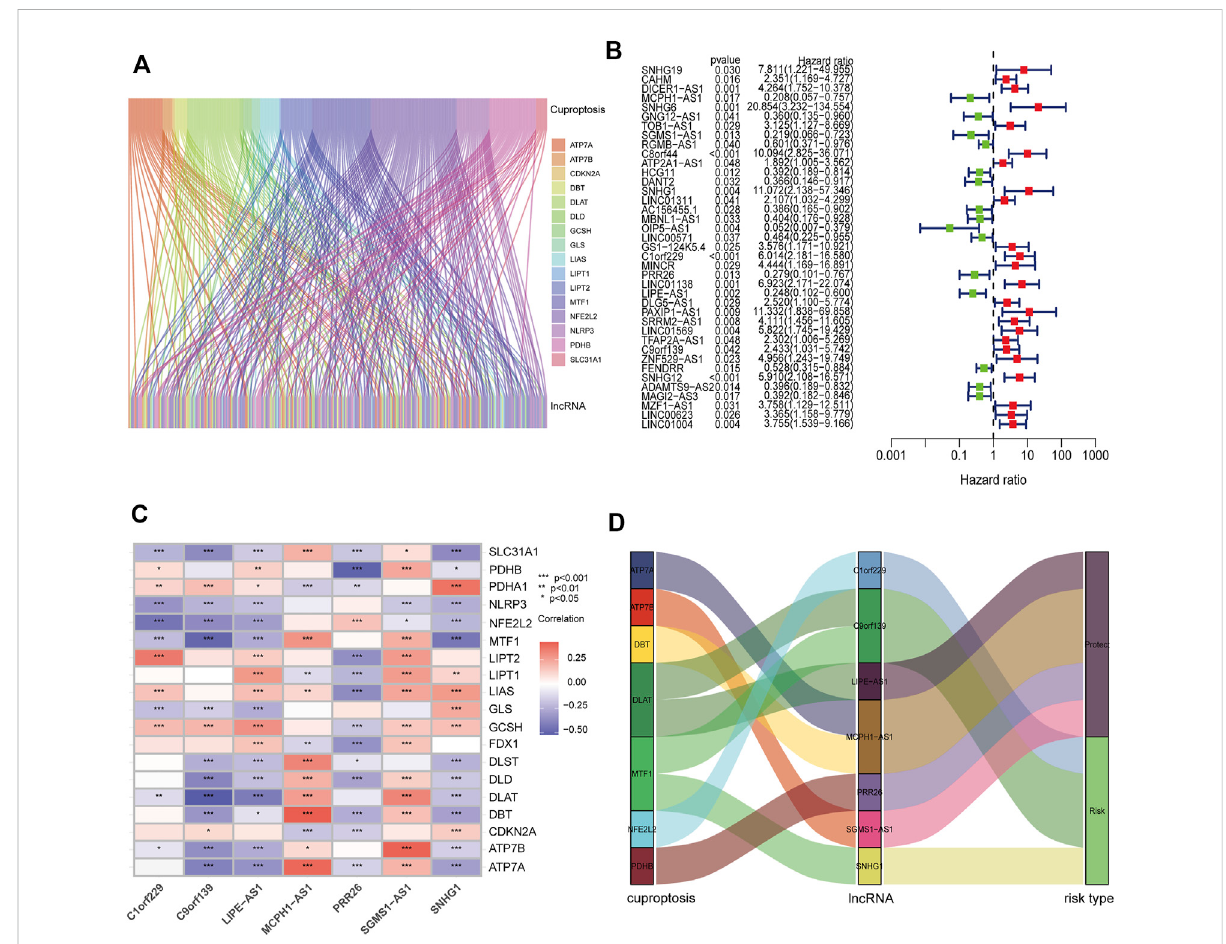
FIGURE 2 Construction of prognostic CRL signature in PCa. (A) Sankey diagram showing the relationships between 173 CRLs and cuproptosis-related genes. (B) Forest plot of 39 prognostic CRLs selectedby univariate Cox regression analysis. (C) Heatmap of the associations between the expression levelsofthesevenCRLsandcuproptosis-relatedgenes. (D) SankeydiagramshowingthecorrelationsofsevenCRLs,cuproptosis-relatedgenes,and risk